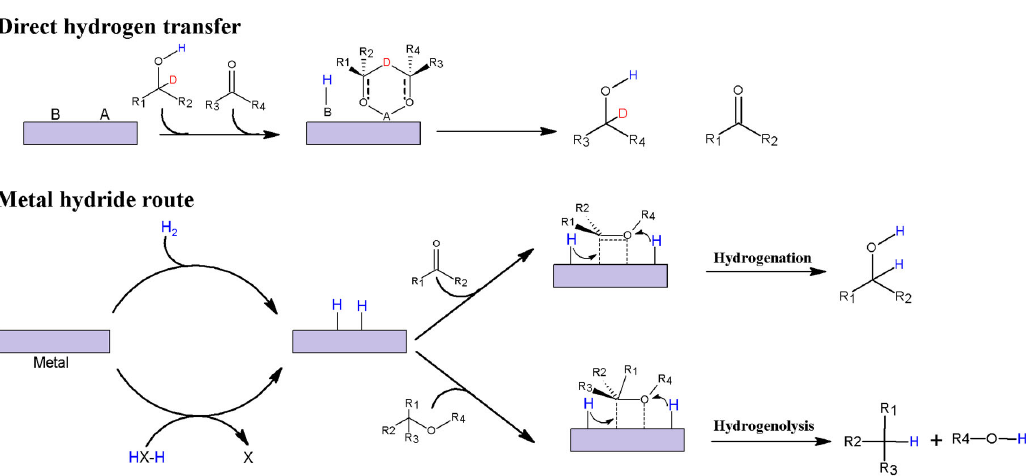
Table 2. Catalytic activity of Cu ‐ based catalysts for conversion of FUR to FOL through CTH. Catalyst